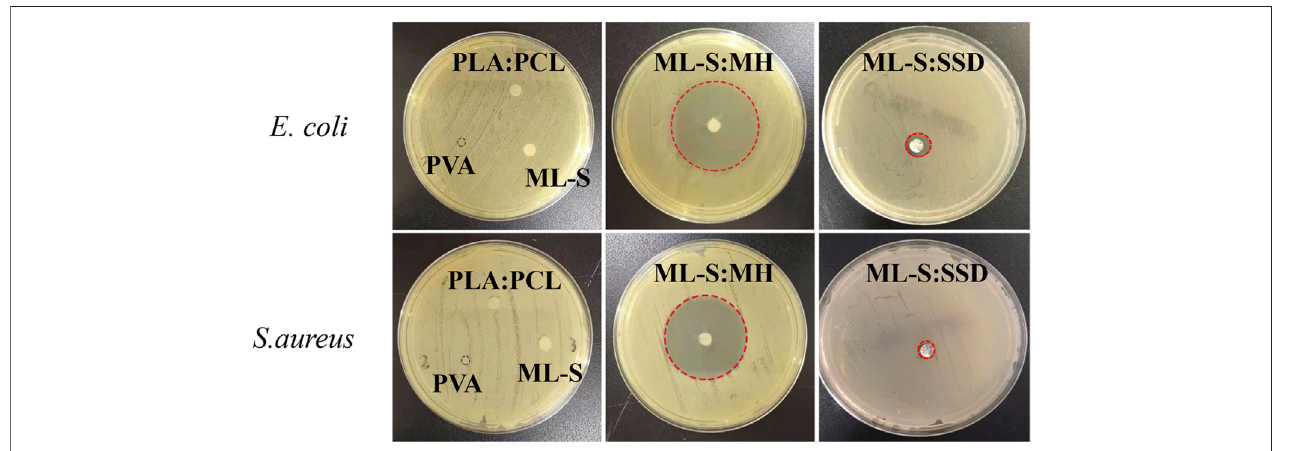
FIGURE 10 | Antimicrobial activity of PLA:PCL, PVA, ML-S, ML-S:MH, and ML-S: SSD.